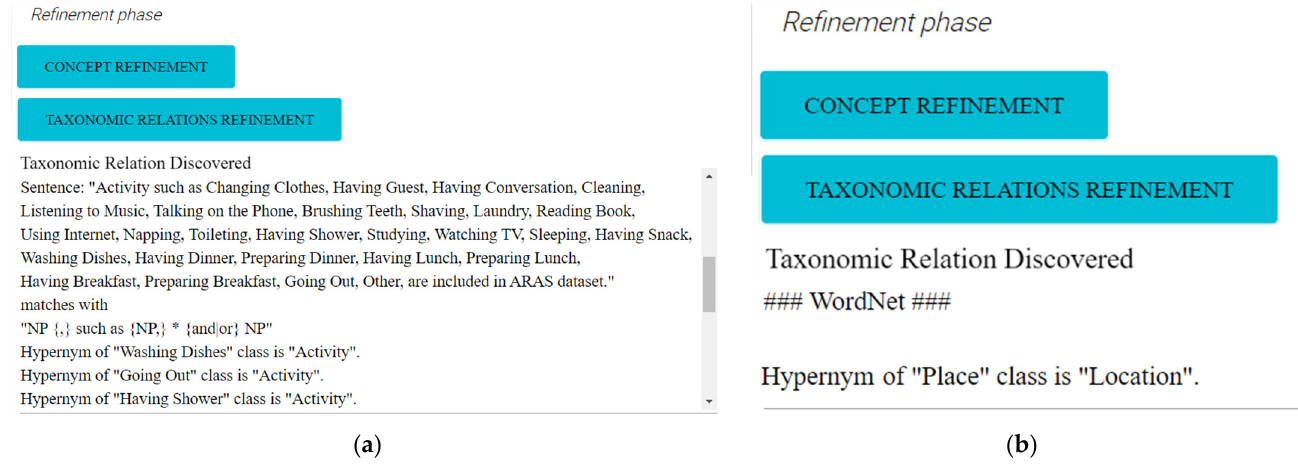
Figure 18. Ontology-based model learning at t 2 in the refinement phase. ( a ) An example of taxonomic refinement using LSPs. ( b ) An example of taxonomic refinement using WordNet.